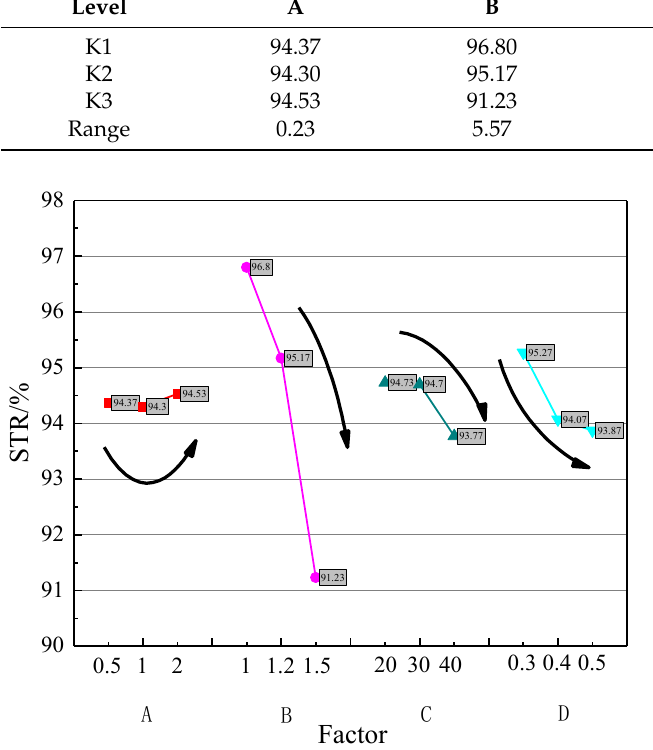
Figure 6. Trend chart of the influence of various factors on STR.